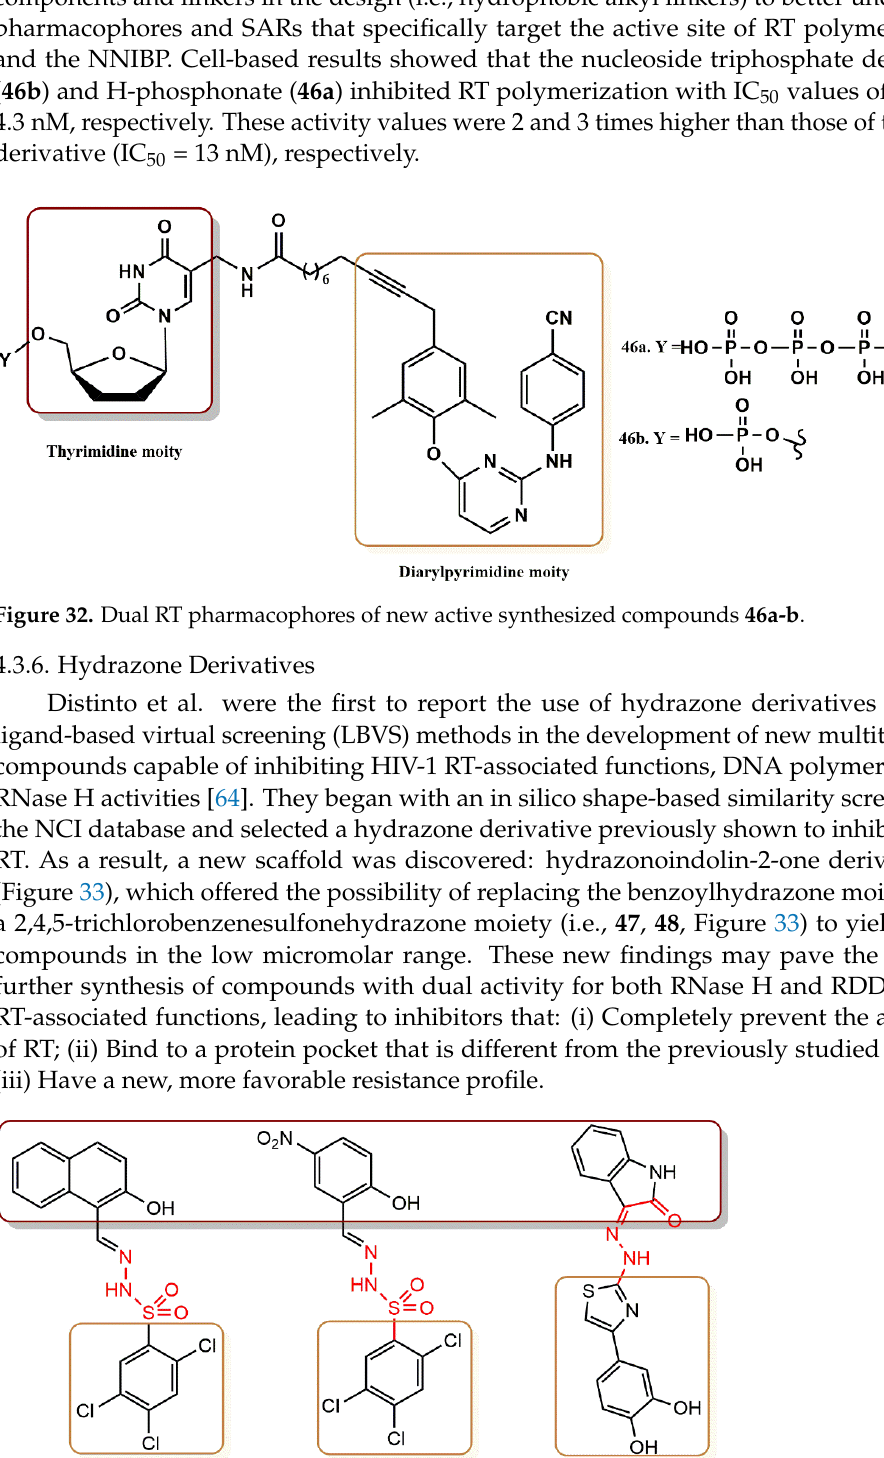
Figure 31. Dual RT pharmacophores of new active synthesized compounds 45a-h.